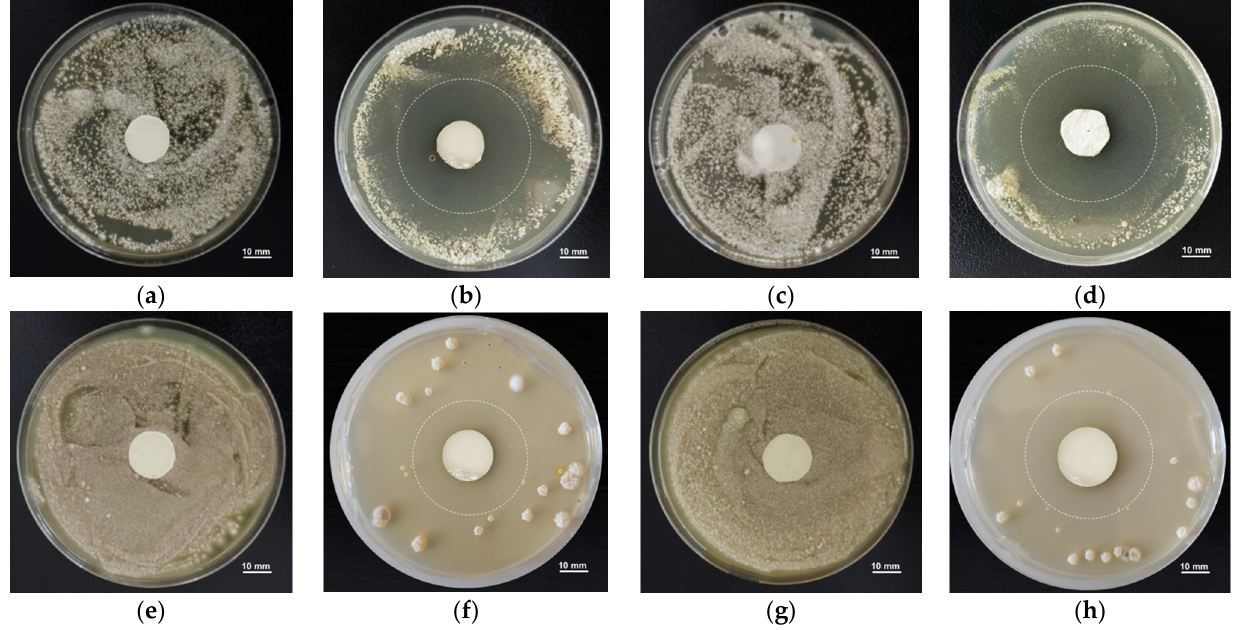
Figure 9. Digital images of the zones of inhibition against P. chlamydospora ( a – d ) and P. aleophilum ( e – h ) after the contact of the fibrous materials with fungi cells: ( a , e )-PVP in PHB mat; ( b , f )-PVP,CQ in PHB mat; ( c , g )-PHB mat; and ( d , h )-PVP,CQ on PHB mat; scale bar = 10 mm.